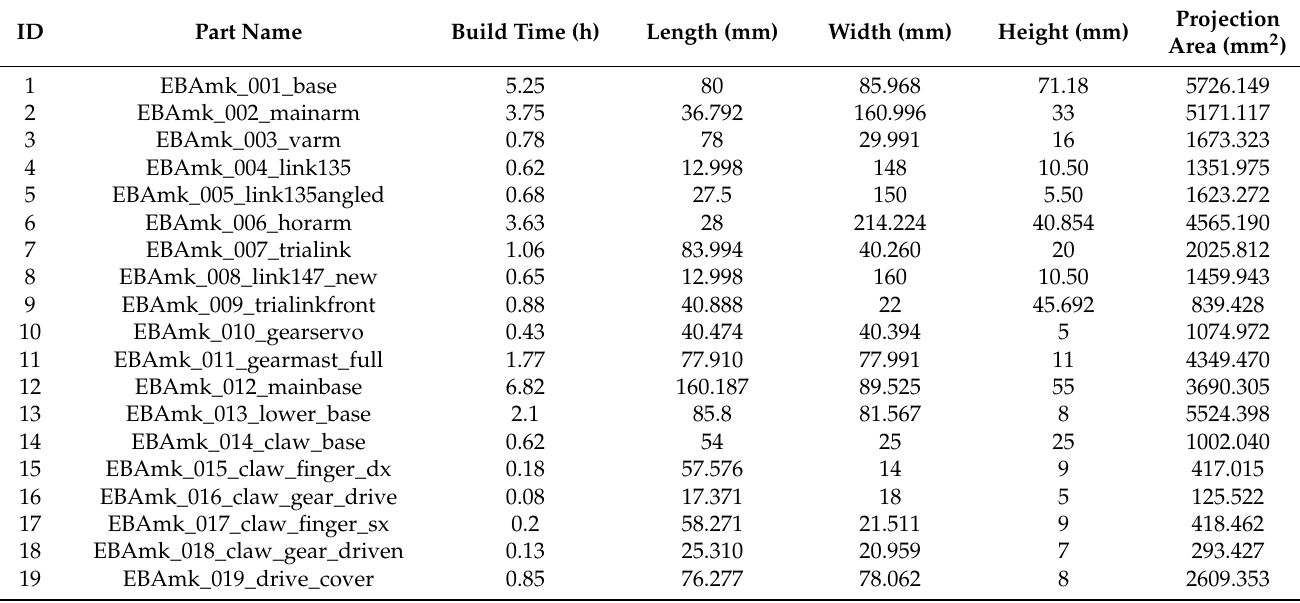
Table 1. Sample data related to the parts used for the case study.